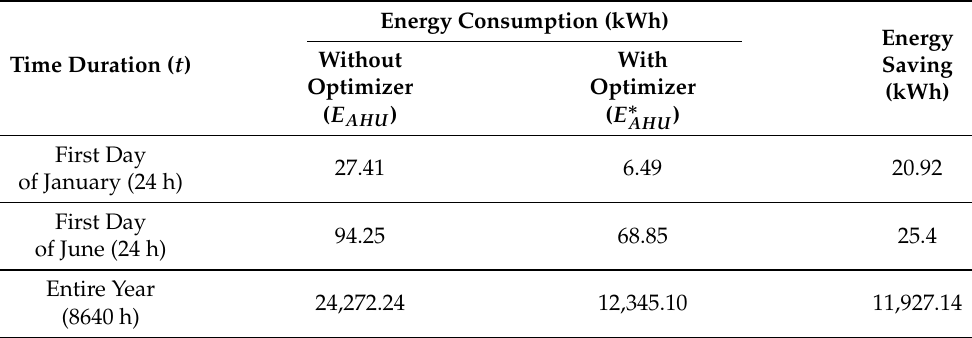
Table 2. Overall energy performance of the AHU in kWh.